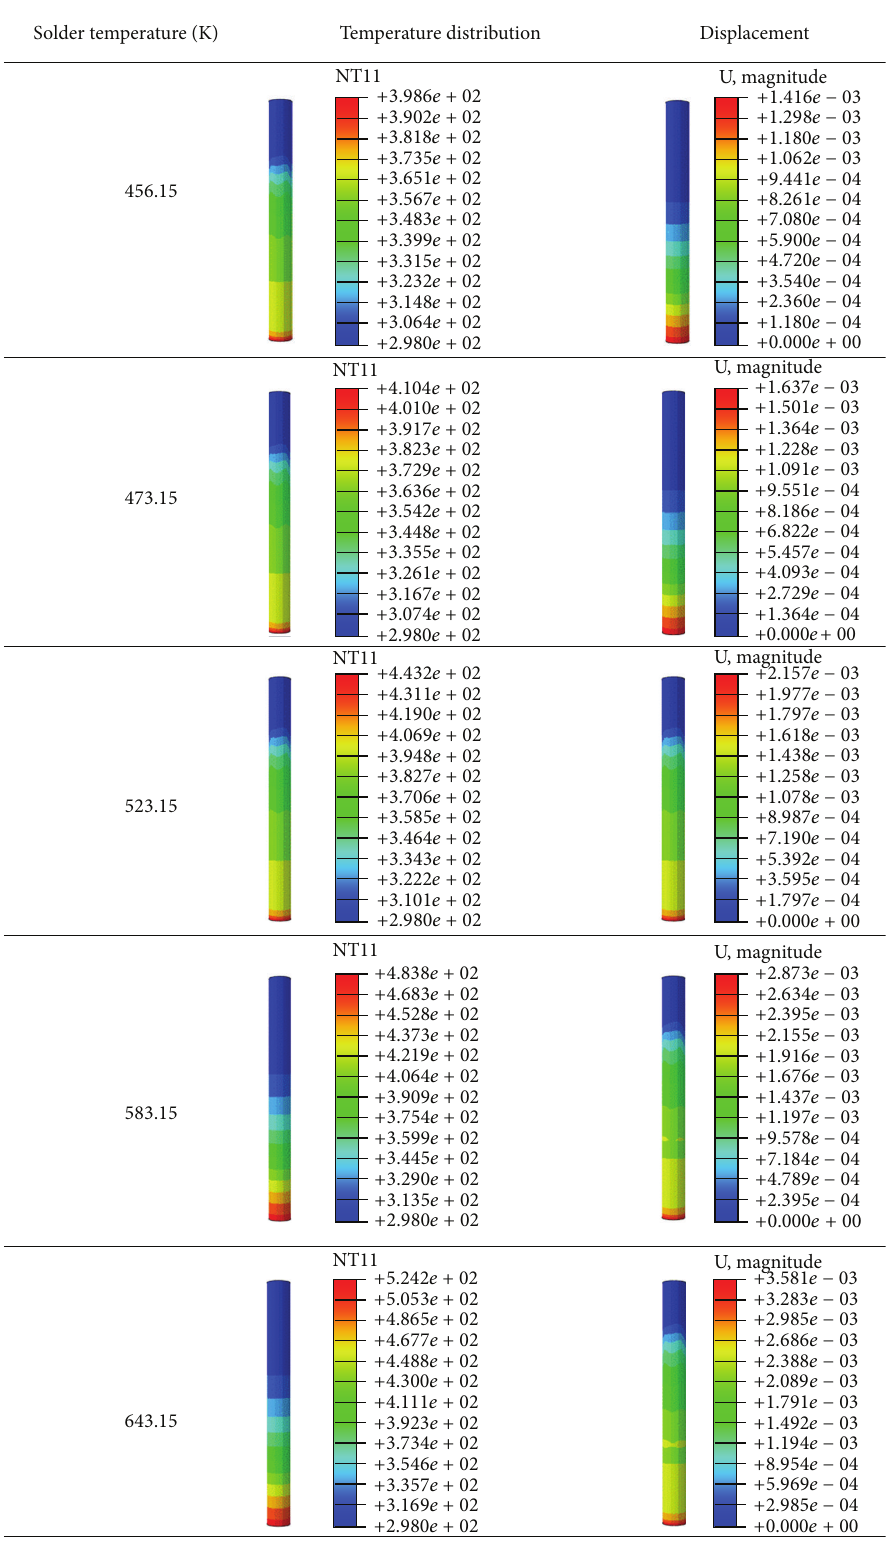
Figure 13: Temperature distribution and displacement at 75%